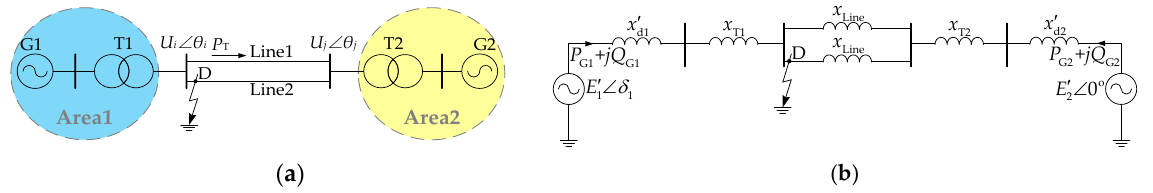
Figure 3. A typical two-area interconnected power system. ( a ) The wiring diagram. ( b ) The circuit